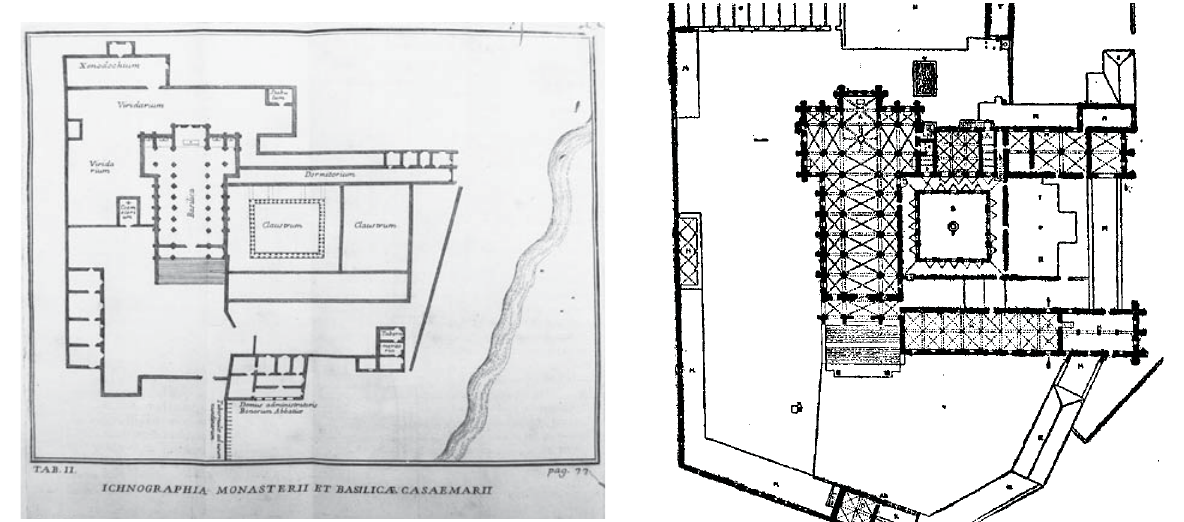
(1894)Figure 2a. Plan of F. Rondinini (1207)